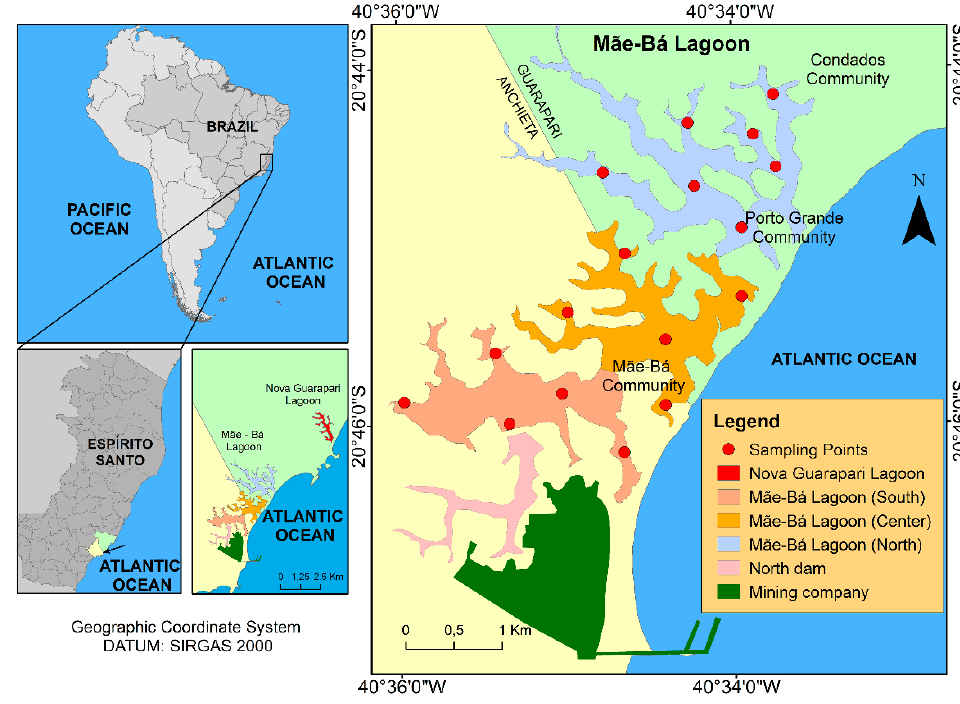
Figure 1. Location of Mãe-Bá Lagoon in Espírito Santo state, Brazil.